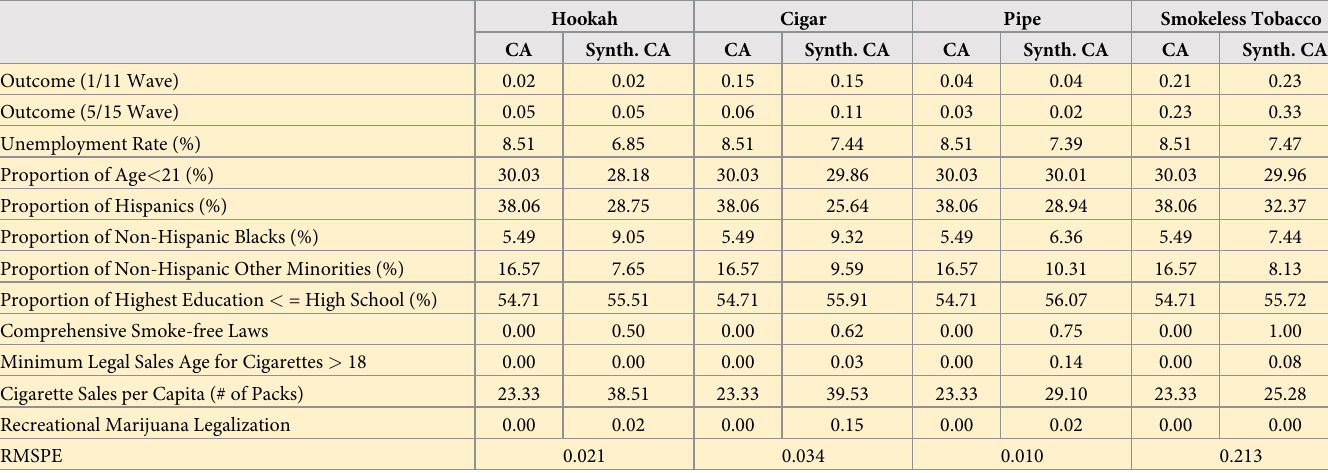
Table 3. Descriptive statistics of predictor variables in California and synthetic control: Non-cigarette use outcomes–daily use. Hookah Cigar